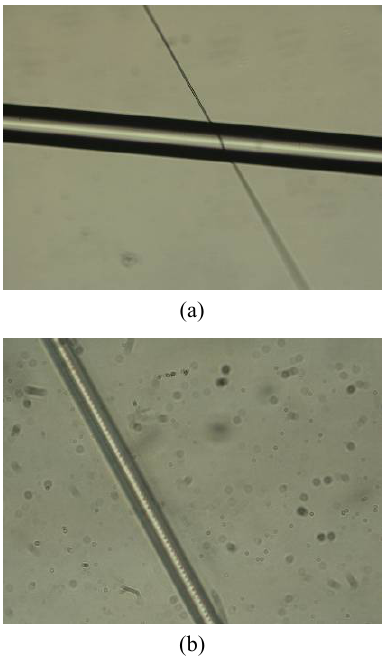
Fig. 1 Femtosecond laser fabrication of microfiber: (a) a section of microfiber with diameter of about 10  m and (b) periodic grating structure on a microfiber.